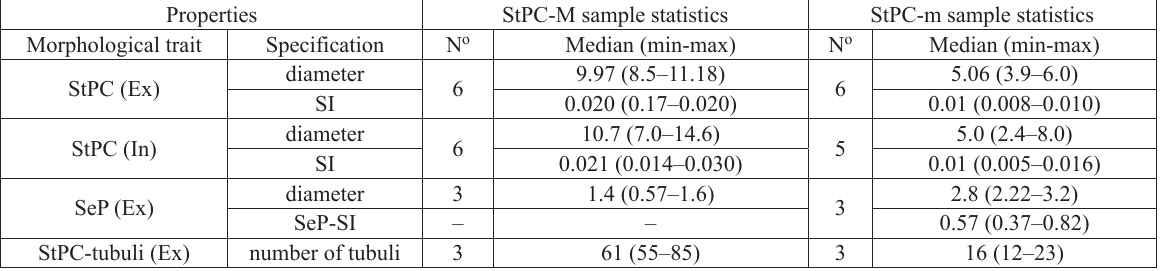
Table 2. Characterization of sieve-type normal pore canals (StPC) of Minyocythere angulata sp. nov. Abbreviations: StPC-M, macro sieve-type pore canals; StPC-m, micro sieve-type pore canals; Ex/In, view of the trait on the external/internal side of the valve; SI, Size Index (ratio of the pore diameter to the valve’s length); SeP, setal pore of the StPC; SeP-SI, Setal Pore Size Index (ratio of the SeP diameter to the StPC diameter); diameter (in μ m), expressed either as individual value or through the median statistics and min-max values; N o , number of observations; v, variate (single